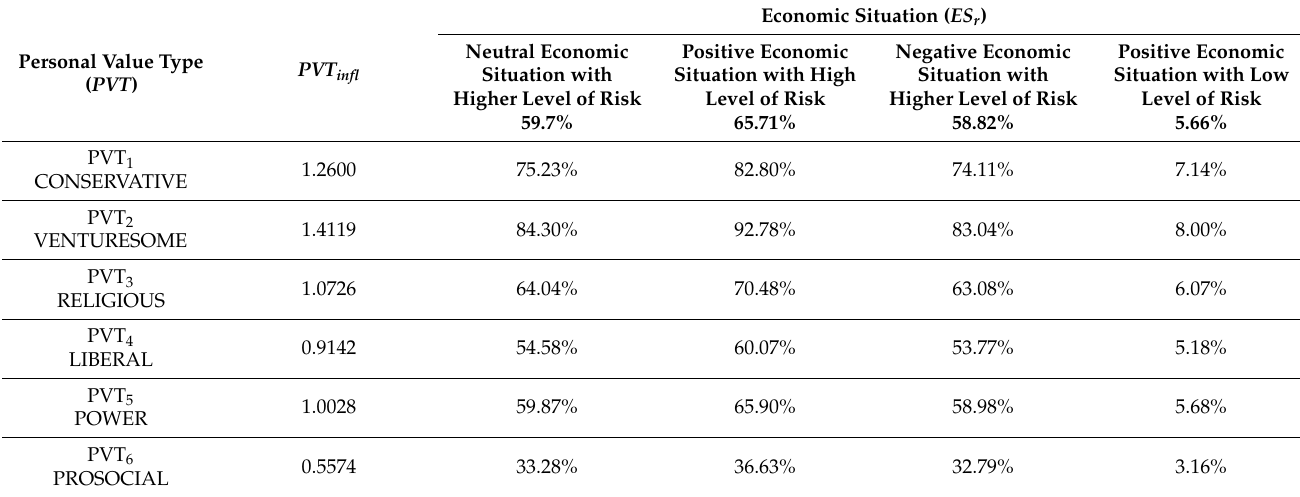
Chart 2. Value-based financial risk prediction model. Table 8. Anticipated personal risk levels for financial risk